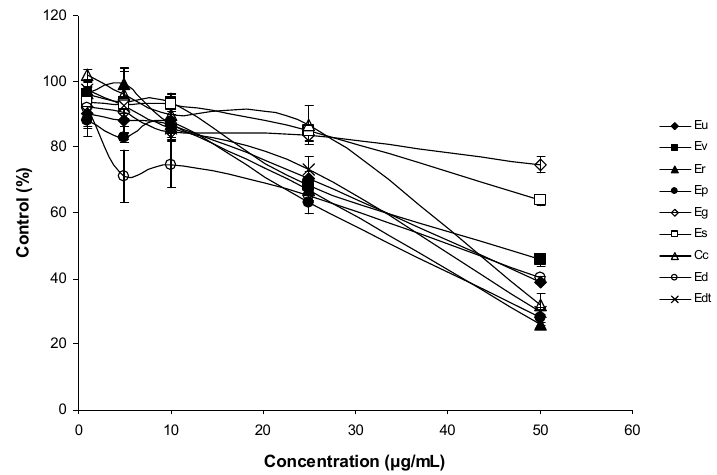
Figure 2. Antiproliferative activity of the EOs on THP-1 cell line after 24 h of exposure. The mean absorbance values for the negative control (dimethyl-sulfoxide (DMSO)-treated cells) were standardized as 100% absorbance (i.e., no growth inhibition) and results were displayed as absorbance (% of control) versus essential oil concentration.